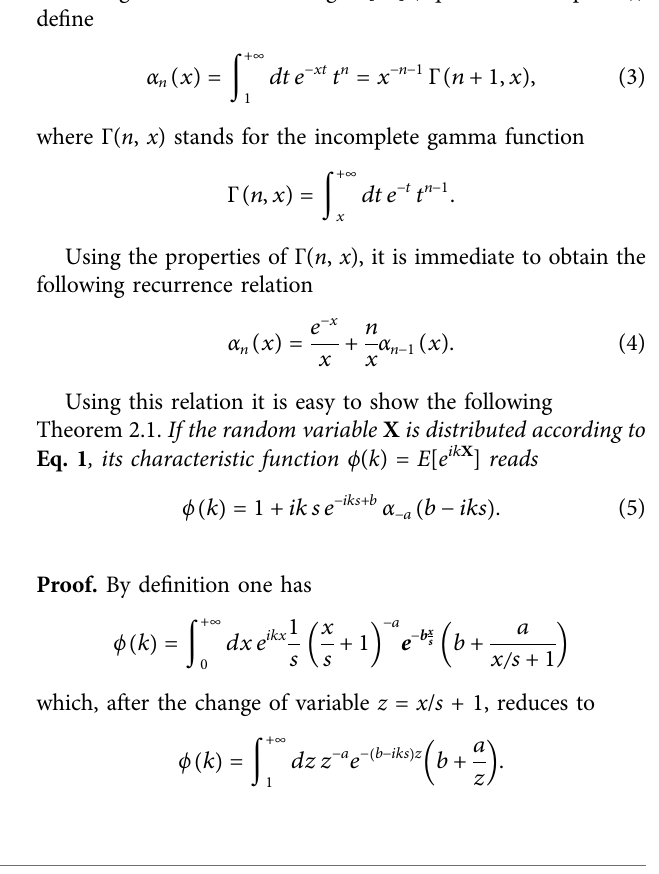
Frontiers in Physics |